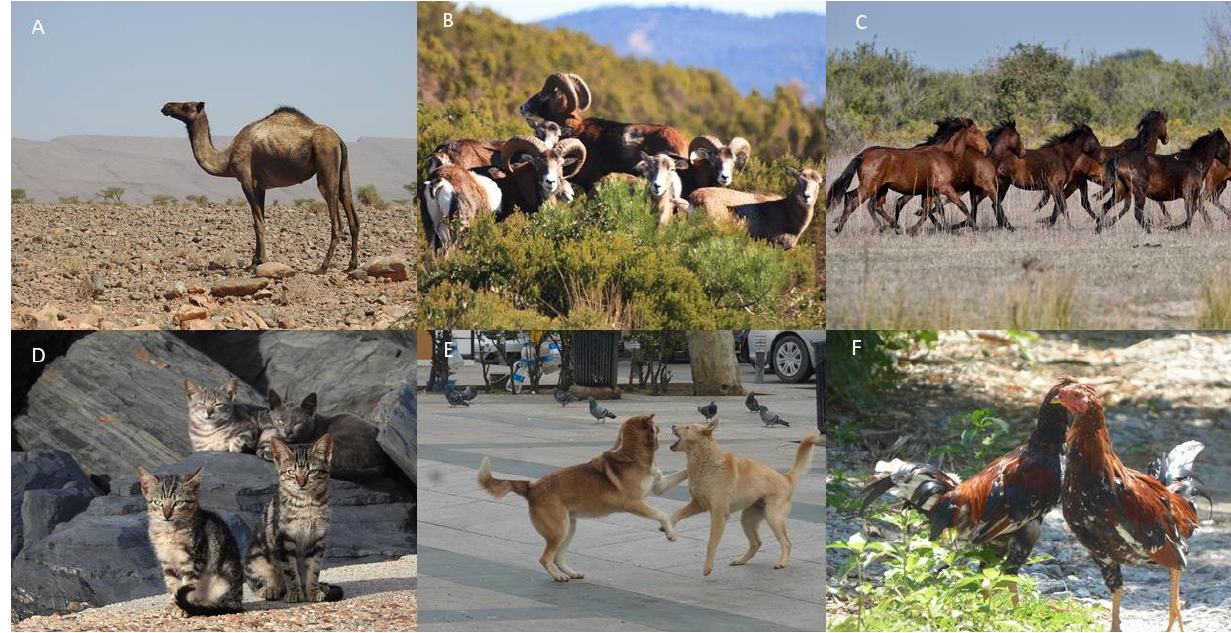
Figure 1. Examples of feral animals considered of conservation interest ( A – C ) or as a risk for biodiversity ( D – F ). Note that the consideration of interest or risk applies only to particular areas. ( A )